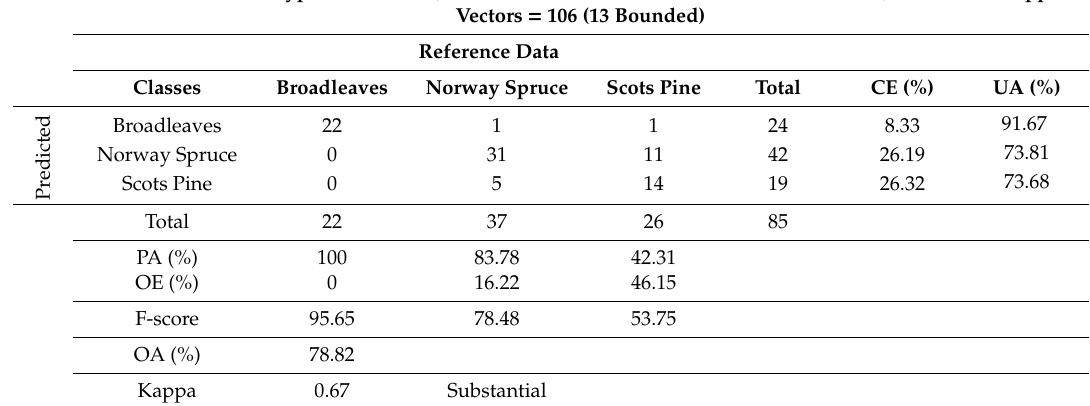
Table 4. Tree species classification summary table and confusion matrix using selected VI layers.